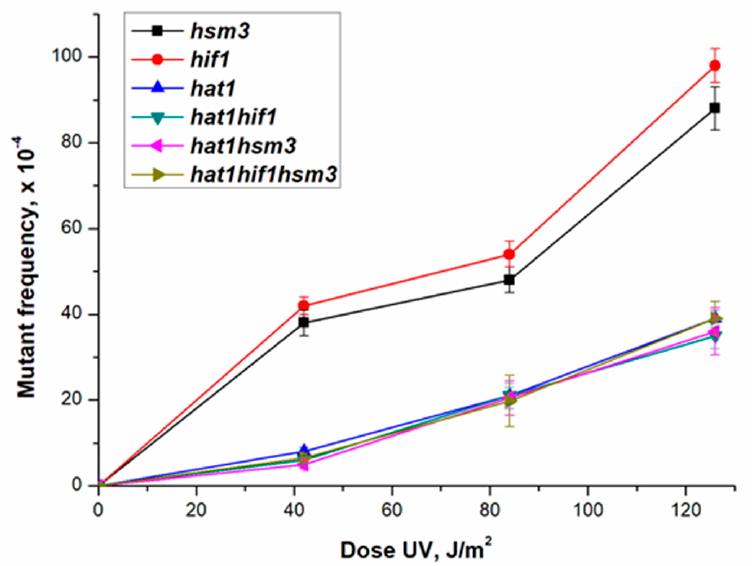
Figure 4. UV-induced mutagenesis in mutant strains hsm3 ∆ (5-LGM-3031), hif1 ∆ (CAY-3), hat1 ∆ (CAY-2), hat1 ∆ hif1 ∆ (CAY-11), hat1 ∆ hsm3 ∆ (CAY-15), and hat1 ∆ hif1 ∆ hsm3 ∆ (CAY-10) at different UV doses.